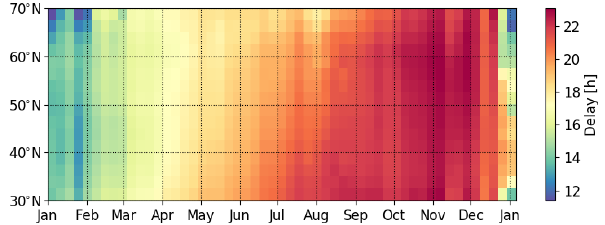
Figure 15. Time series of the delay of TEC with respect to EUV as an epoch plot for the mid-latitudes covering Europe within the time period from January 2011 to December 2013. The delay varies between ≈ 11 . 3 and ≈ 23 . 1h. The absolute correlation coefficient is ≈ 0 . 21 during the